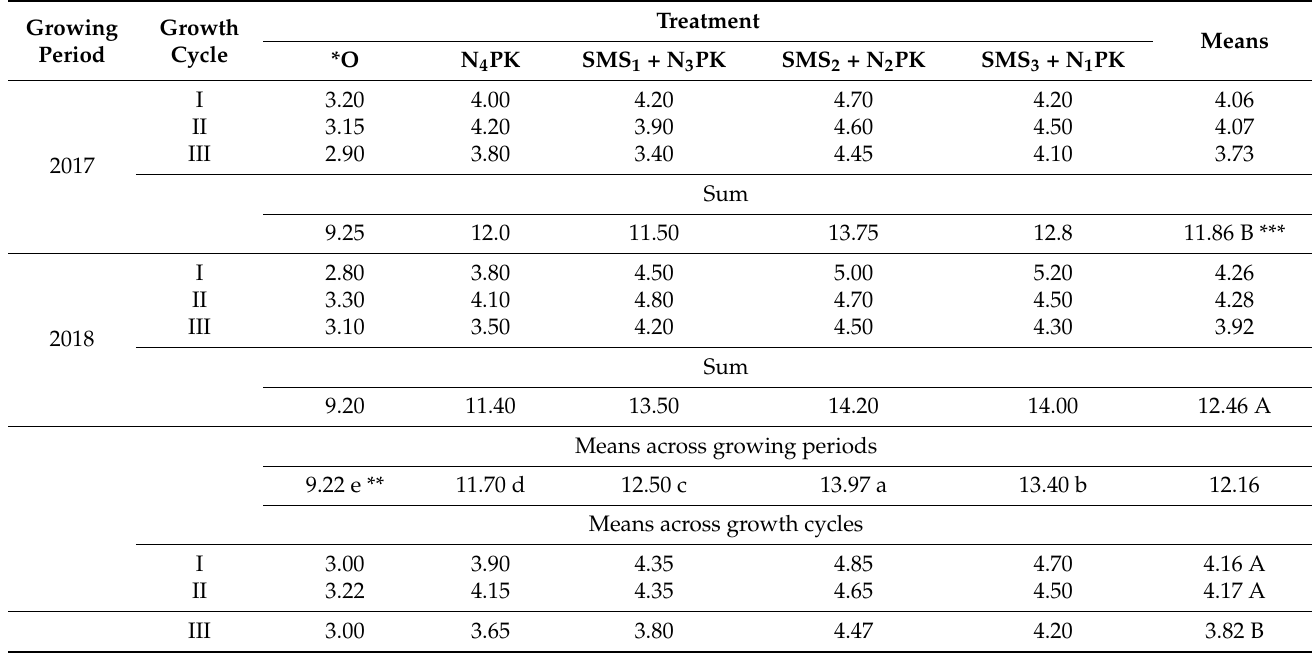
Table 2. The effect of fertilizer treatment, growing period and growth cycle on Festulolium braunii yield (Mg · ha − 1